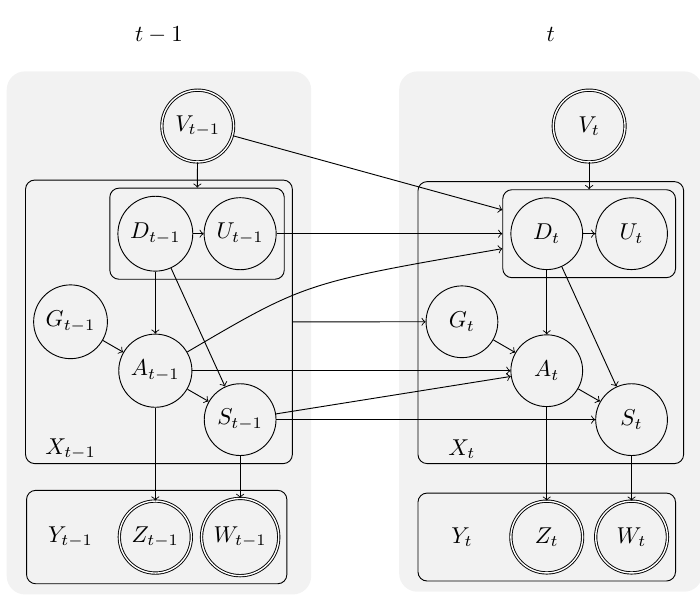
Figure 5. DBN structure of a CCBM model. Adapted from